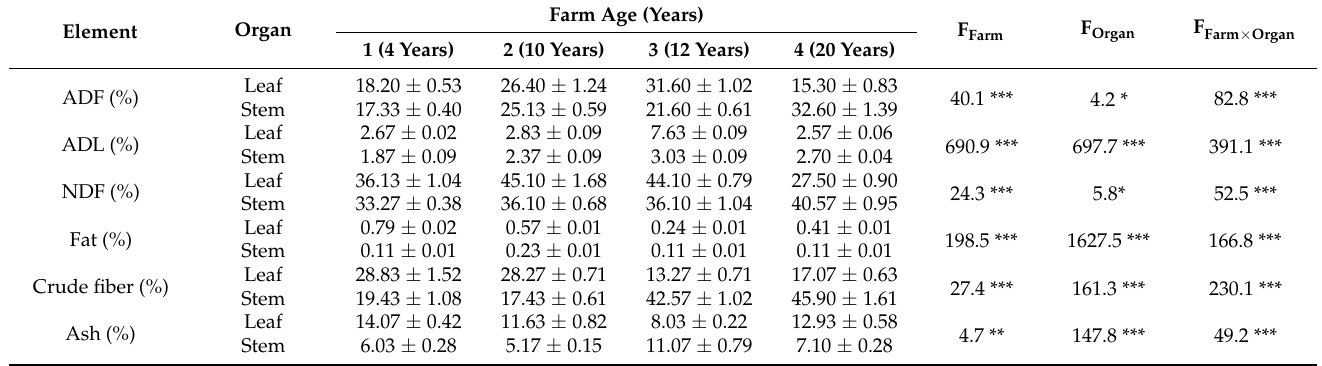
Table 4. Mean ( ± standard error, n = 6) organic nutrient contents of Taif Rose populations grown in four farms in the mountainous area of Taif City in Saudi